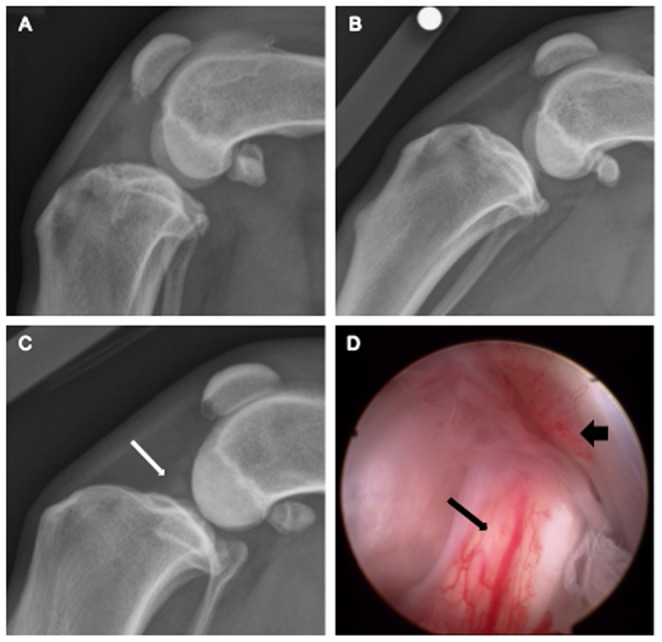
Lateral radiographic images of the stifle (A–C).(A) Index stifle with marked osteophytosis and effusion. (B) Contralateral stifle with mild osteophytosis and moderate effusion. (C) Contralateral stifle with no radiographic osteophytosis and mild effusion (white arrow). (D) Same contralateral stifle from image ‘C’ with minimal radiographic changes demonstrating obvious synovitis and fraying of the cranial cruciate ligament (narrow black arrow) and inflammation of the synovium overlying the caudal cruciate ligament (broad black arrowhead).